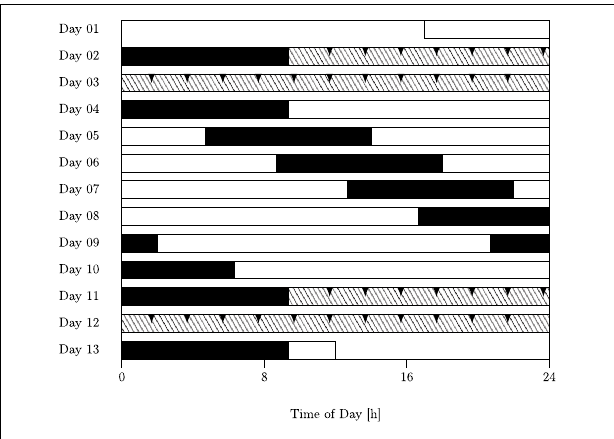
FIGURE 2 | Forced desynchrony (FD) protocol. Filled bars, scheduled sleep (0 lx); open bars, wakefulness in dim light (15 lx); hatched bars, constant routine (CR). The FD protocol used in this study was a 28-h sleep–wake cycle consisting of alternating epochs of 9.33 h of sleep and 18.67 h of wakefulness. Interval timing tasks were administered at two-hourly intervals throughout both CRs (Days 2–3; Days 11–12; reported here; arrows indicate sampling points) as well as across the central part of the FD protocol (evening of Day 7 to afternoon of Day 8; not reported